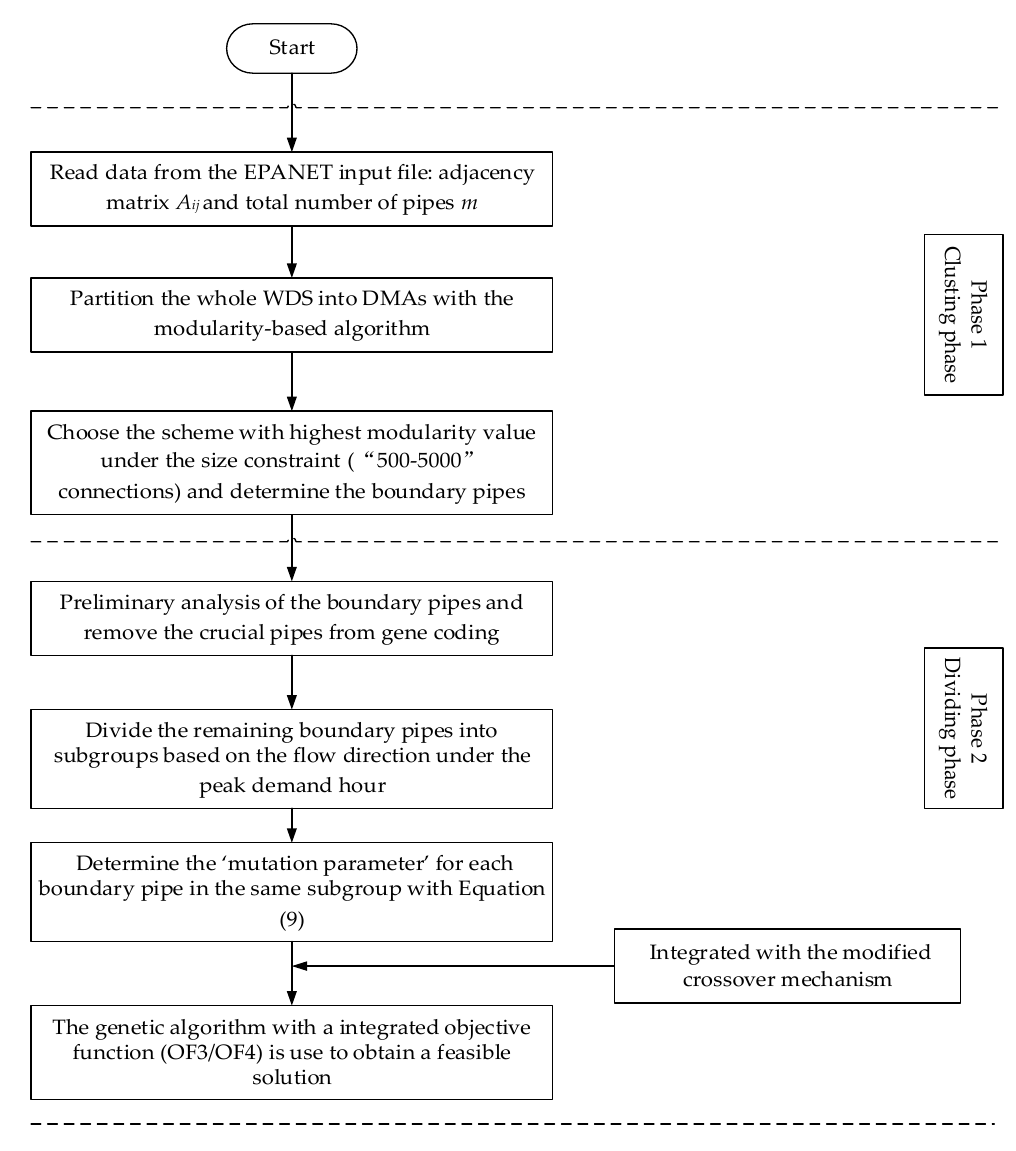
Figure 1. Flowchart of the whole methodology.